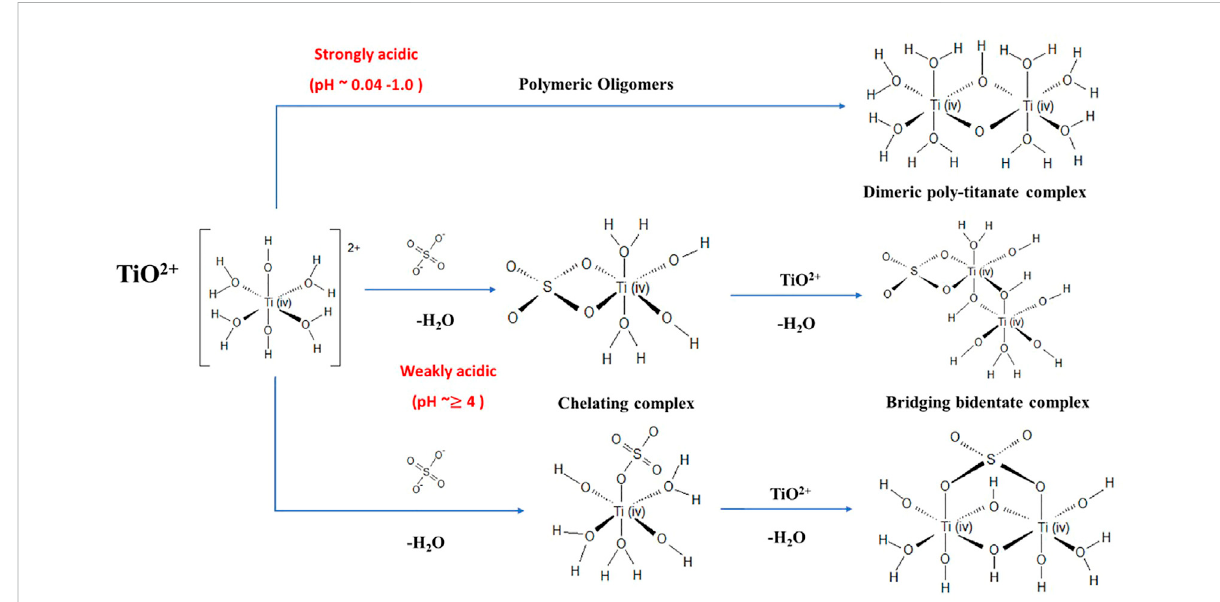
FIGURE 2 Schematic representation of various Ti 4+ complexes under weakly and strongly acidic